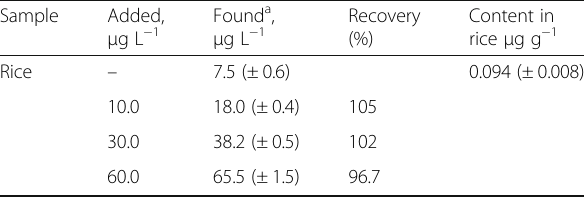
Table 6 Results for determination of Cu(II) ions in rice